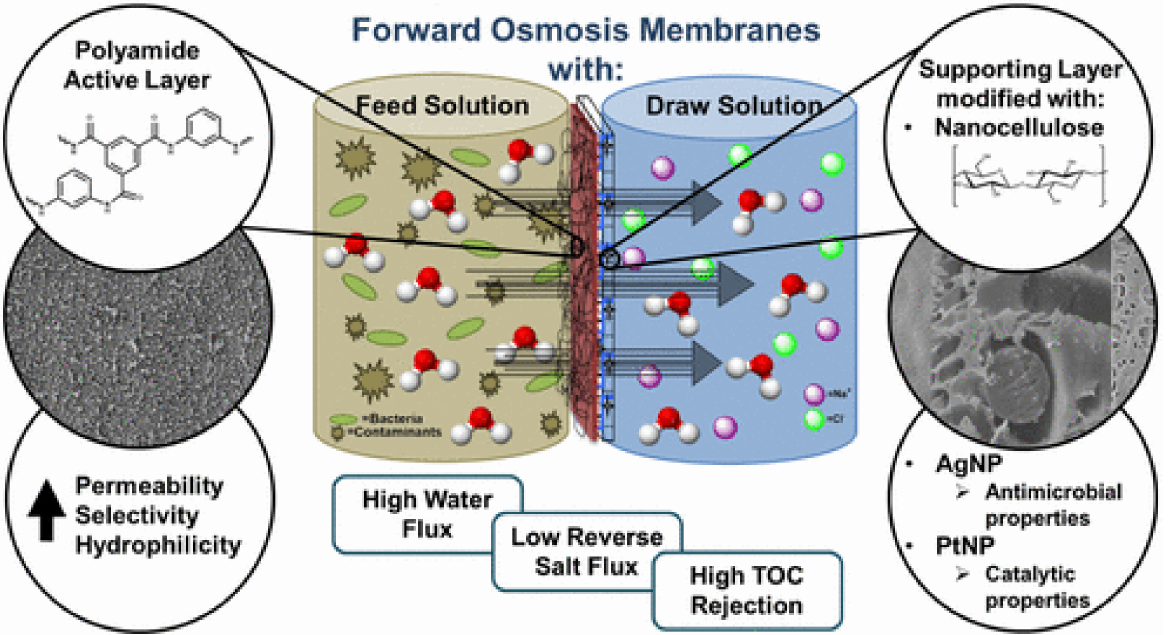
Figure 10. Enhanced performance of nanocellulose filter membranes for forwarding osmosis through modification of the nanocellulose material surface by coating with a polymer (e.g., polyamide active layer), and by nanoparticle (NP) deposition (e.g., Ag, Pt) [220], ©American Chemical Society, 2017. TOC, total organic